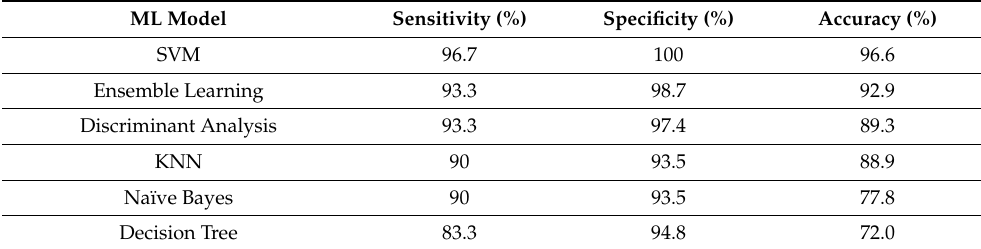
Table 5. Results of the three-class classification approach